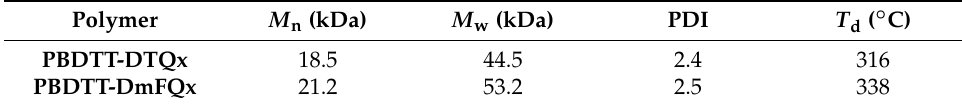
Table 1. Molecular weight and thermal properties of the copolymers.